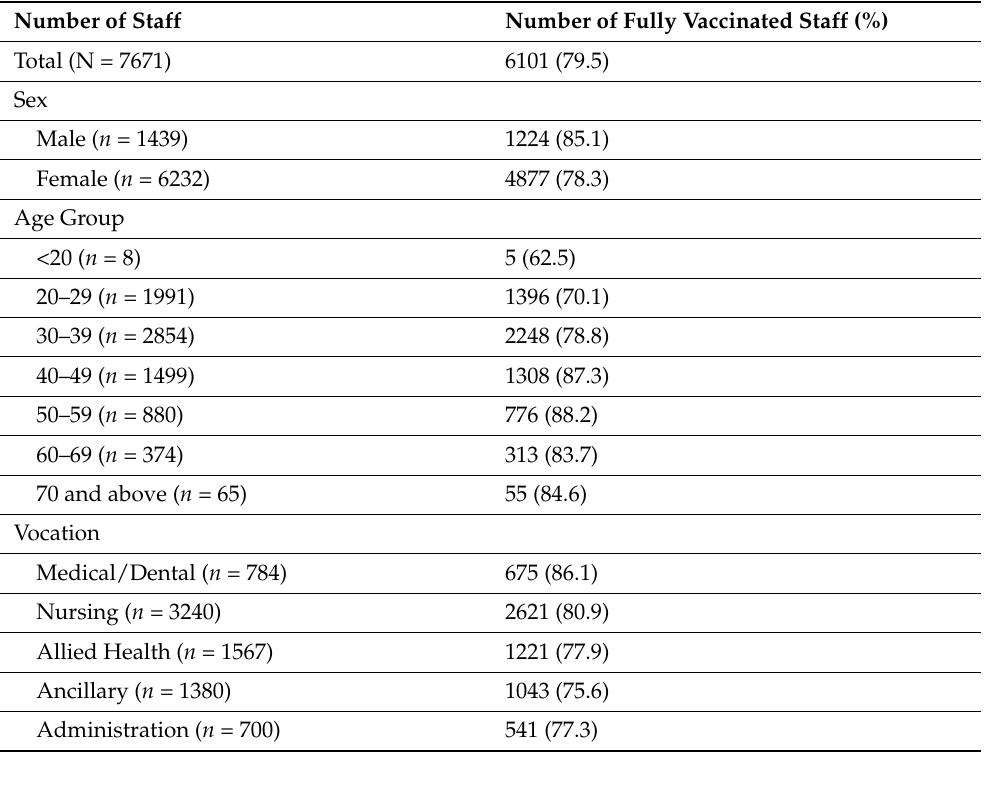
Table 2. Demographics of fully vaccinated staff by late March 2021.